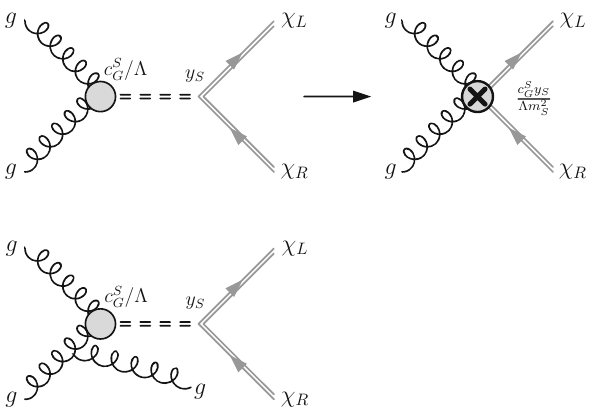
Fig. 2 Relevant diagrams contributing to nuclear interaction with fermionic DM (first row) and corresponding DM observables at hadron colliders (monojet, second row), turning on the interactions ∼ c S ∼ y S . The diagrams are similar for pseudo-scalar mediators, employing the corresponding tilded coefficients